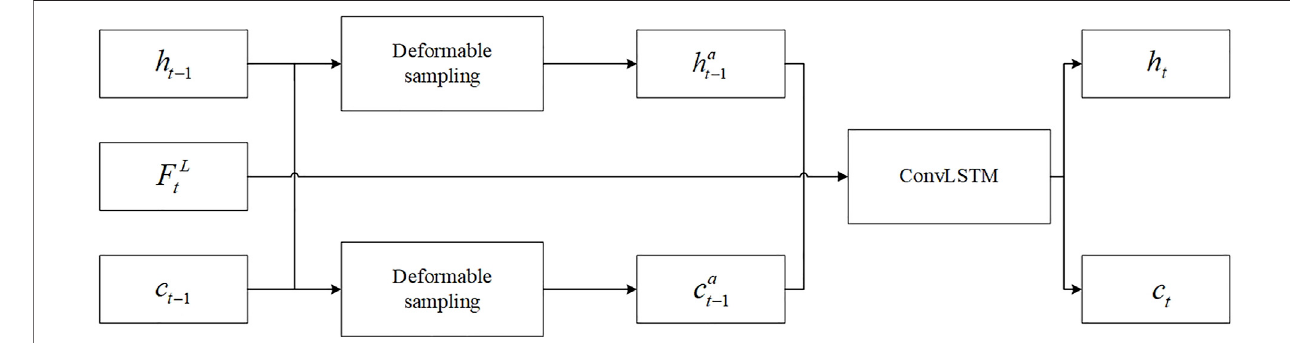
FIGURE 3 | Deformable ConvLSTM.